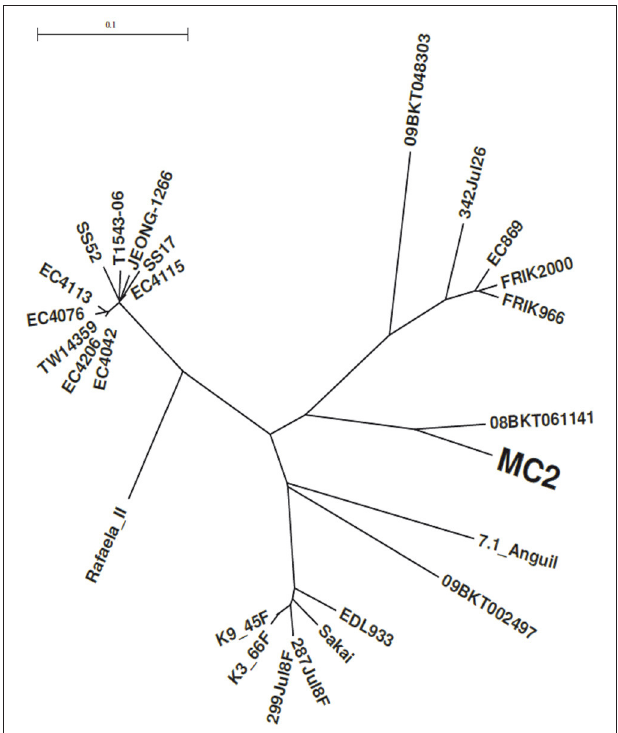
FIGURE 1 | Phylogenetic tree highlighting the position of E. coli MC2 relative to other E. coli O157:H7 strains. The whole genome SNP based phylogeny was established with CSI phylogeny version 1.4 using EDL933 (AE005174.2) as a reference and standard input parameters (see the Materials and Methods section). The unrooted circular tree was generated with Seaview (version 4.5.4.).